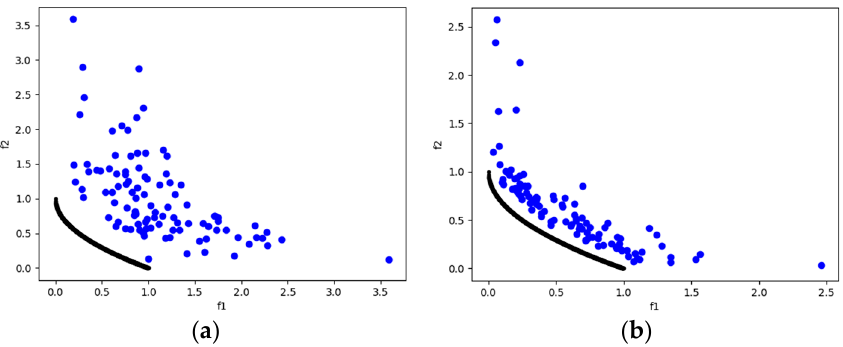
Figure 9. The plots of the approximate PFs with the highest HV value against real PF. ( a ) UF1 approximate PF using MOSA/D-CGO; ( b ) UF1 approximate PF using MOSA/D-DE.